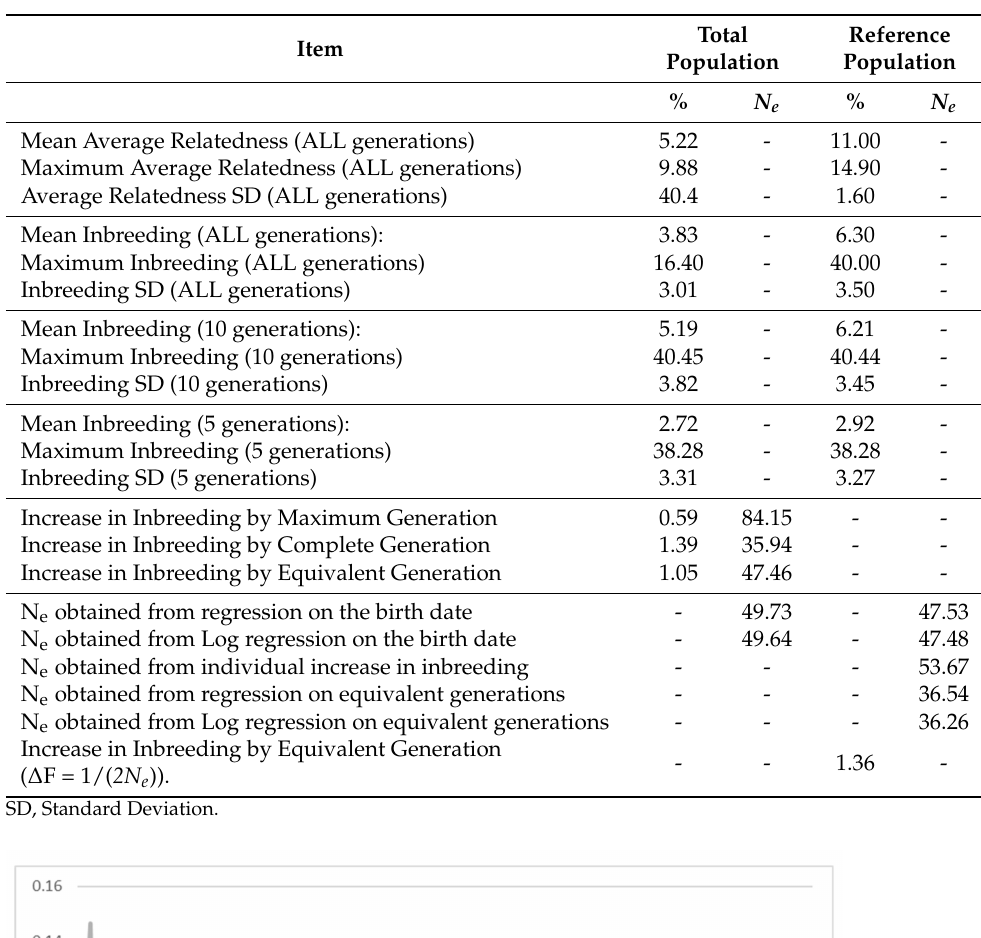
Table 4. Inbreeding, average relatedness and effective population size estimated for the total and reference populations.